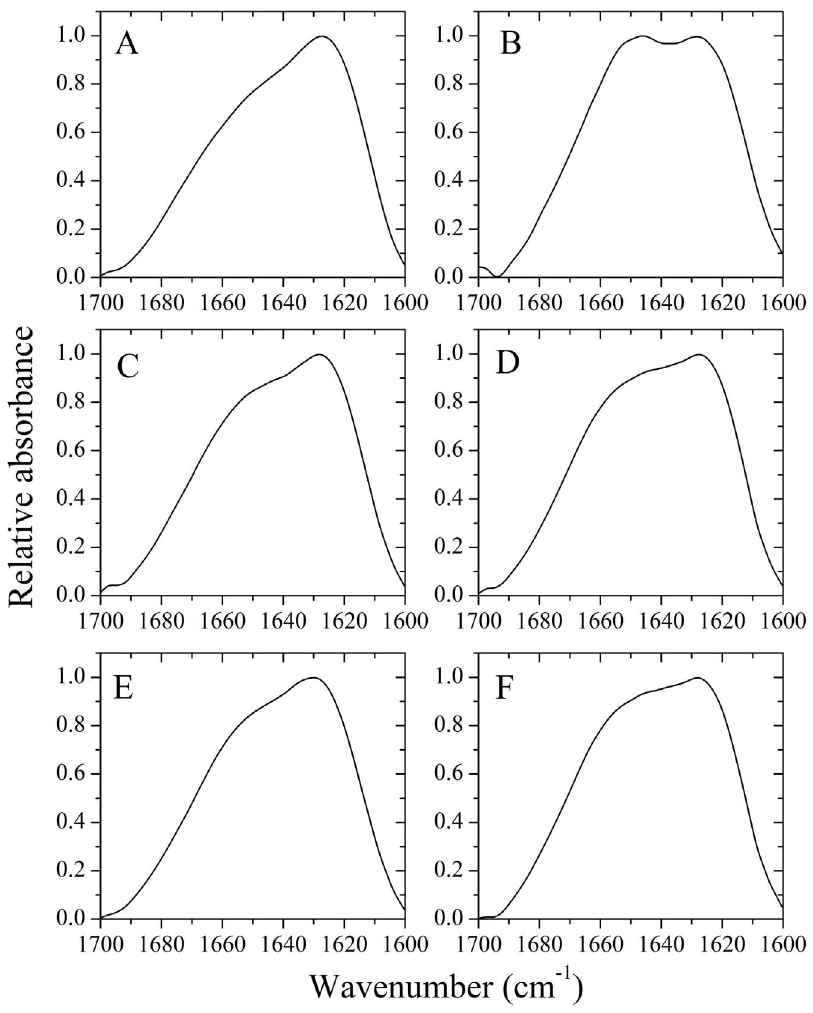
Figure 5. Secondary structural changes of human (A, C, and E) and rabbit (B, D, and F) chimera PrP isoforms monitored by FTIR. The FTIR spectra of amyloid fibrils produced from human chimera and rabbit chimera, in the absence of a crowding agent (A and B) and in the presence of 150 g/l Ficoll 70 (C and D) or 100 g/l Ficoll 400 (E and F), respectively. The incubation time was chosen within a time range of the plateau of each kinetic curve of ThT fluorescence shown in Fig.